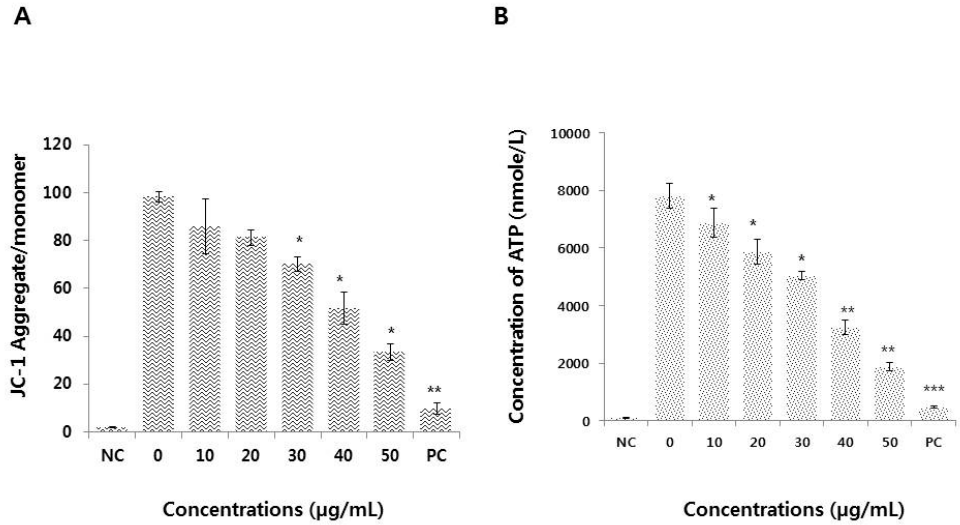
Figure 6. Measurement of MMP and ATP in HEK293 cells. ( A ) HEK293 cells were treated with various concentrations of graphene oxide for 24 h. Changes in MMP were then determined using a cationic fluorescent dye, JC-1. ( B ) ATP levels were measured according to the manufacturer’s instructions (Sigma-Aldrich; Catalog Number MAK135) in HEK293 cells exposed to graphene oxide for 24 h. The results are expressed as the means ± standard deviation of three independent experiments. There were significant di ff erences in the ratios of MMP and ATP production in graphene oxide-treated cells compared to untreated cells. * p < 0.05 was considered significant; ** p < 0.01 was considered highly significant and *** p < 0.001 was considered very highly significant.